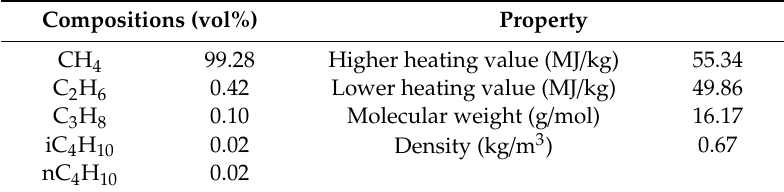
Table 2. The main compositions and properties of natural gas used in the test.